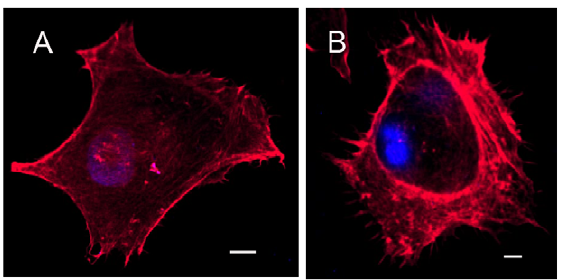
Figure 3. Confocal laser scanning microscope analysis of individual MCF7 (A) and pII (B) cells showing differences in both intensity and arrangement of F actin filaments visualised by phalloidin staining as described in Methods. Microspikes and lamellipodia-like structures are visible in the pII cells. Both photographs were enhanced equally by auto-contrast in Adobe Photoshop. Scale bar indicates 10 m m.